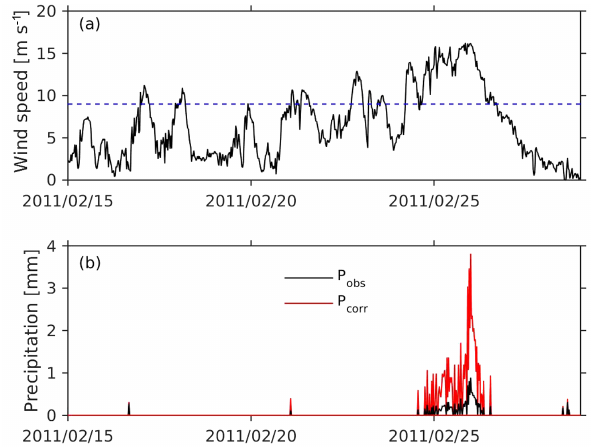
Figure 8. Example of a plausible blowing snow event at TVC site. (a) Wind speed (dashed line: upper wind speed threshold for bias correction), and (b) observed and bias-corrected snowfall over the period from 15 February to 1 March